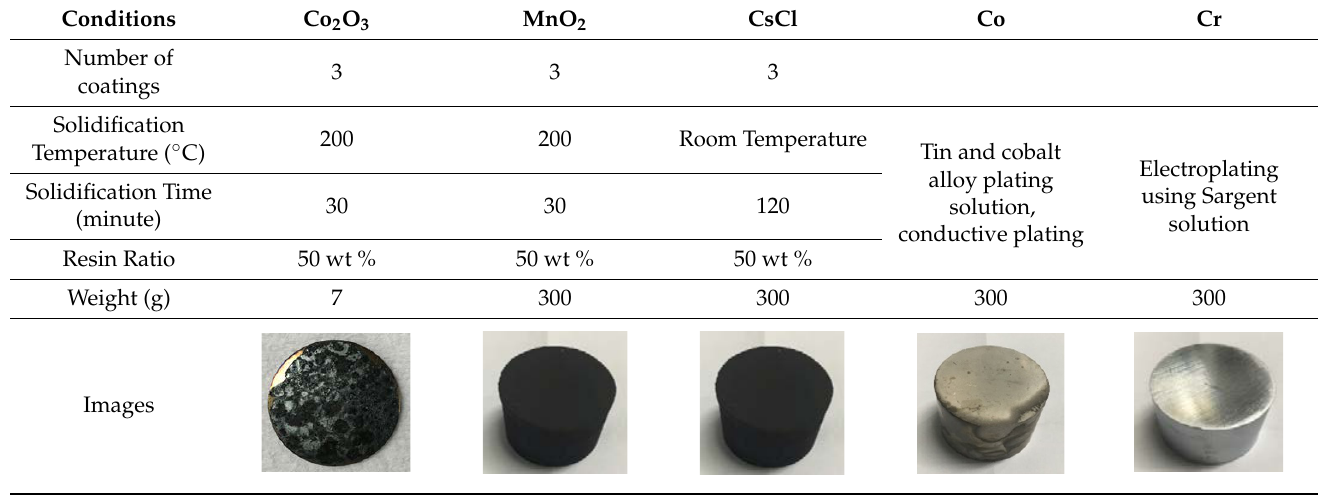
Table 2. SUS304 specimen fabrication methods.